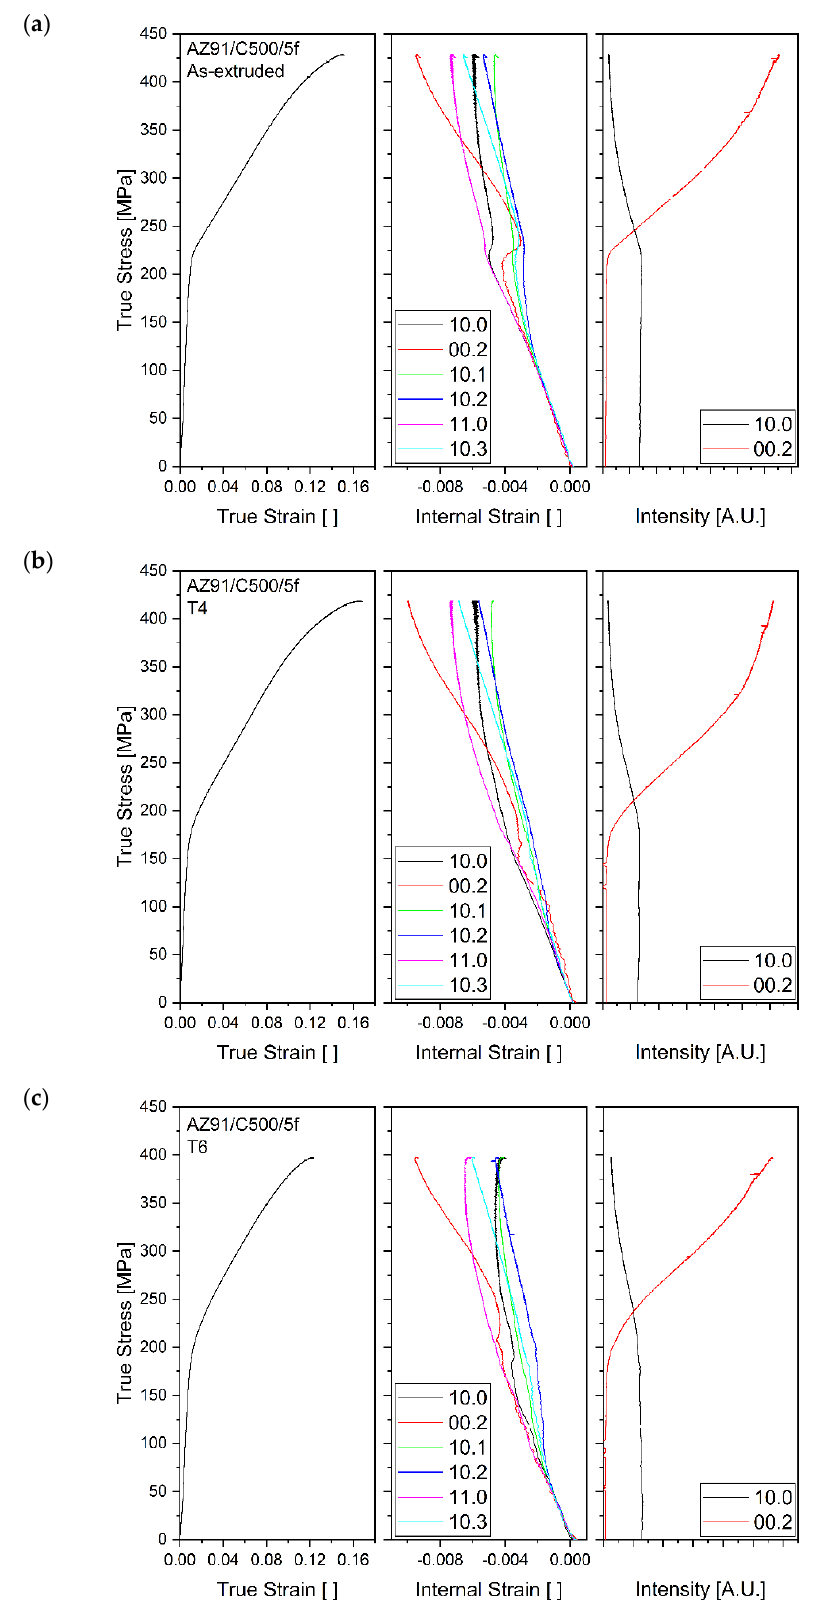
Figure 5. Plots showing macroscopic true strain (left), strain on lattice planes (centre), and intensity (right) against true stress for ( a ) AZ91/C500/5f as extruded; ( b ) AZ91/C500/5f T4; ( c ) AZ91/C500/5f